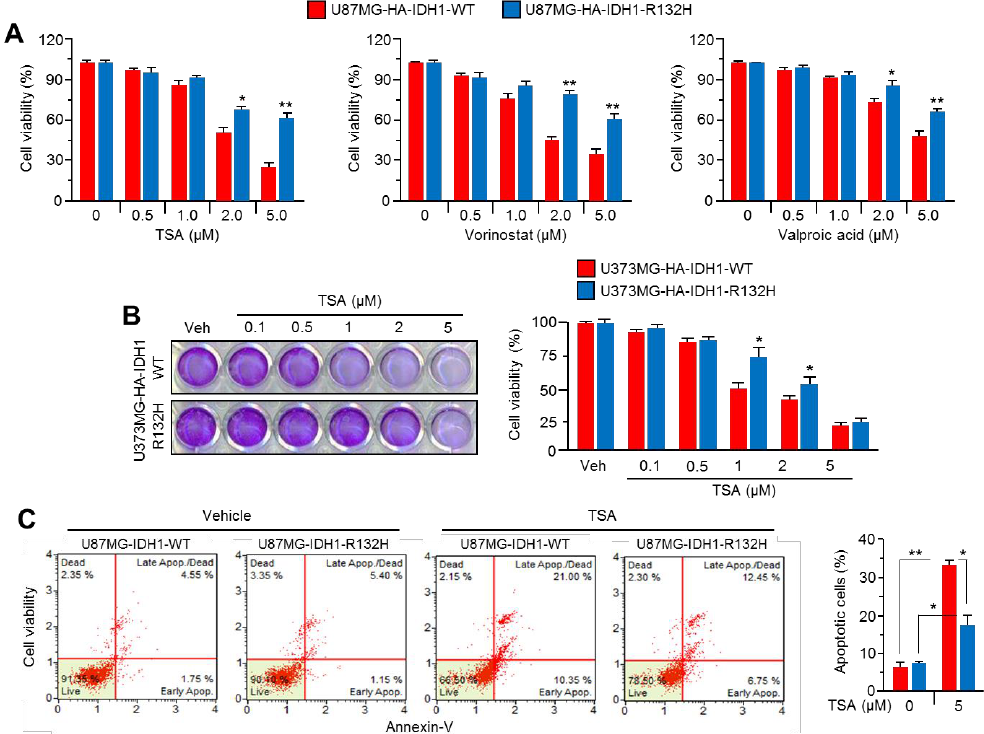
Figure 2. IDH1 R132H overexpression suppresses anti-cancer effect of HDAC inhibitors (HDACi) in glioblastoma cells. ( A ) IDH1-WT or IDH1 R132H overexpressing stable U87MG cells were incubated